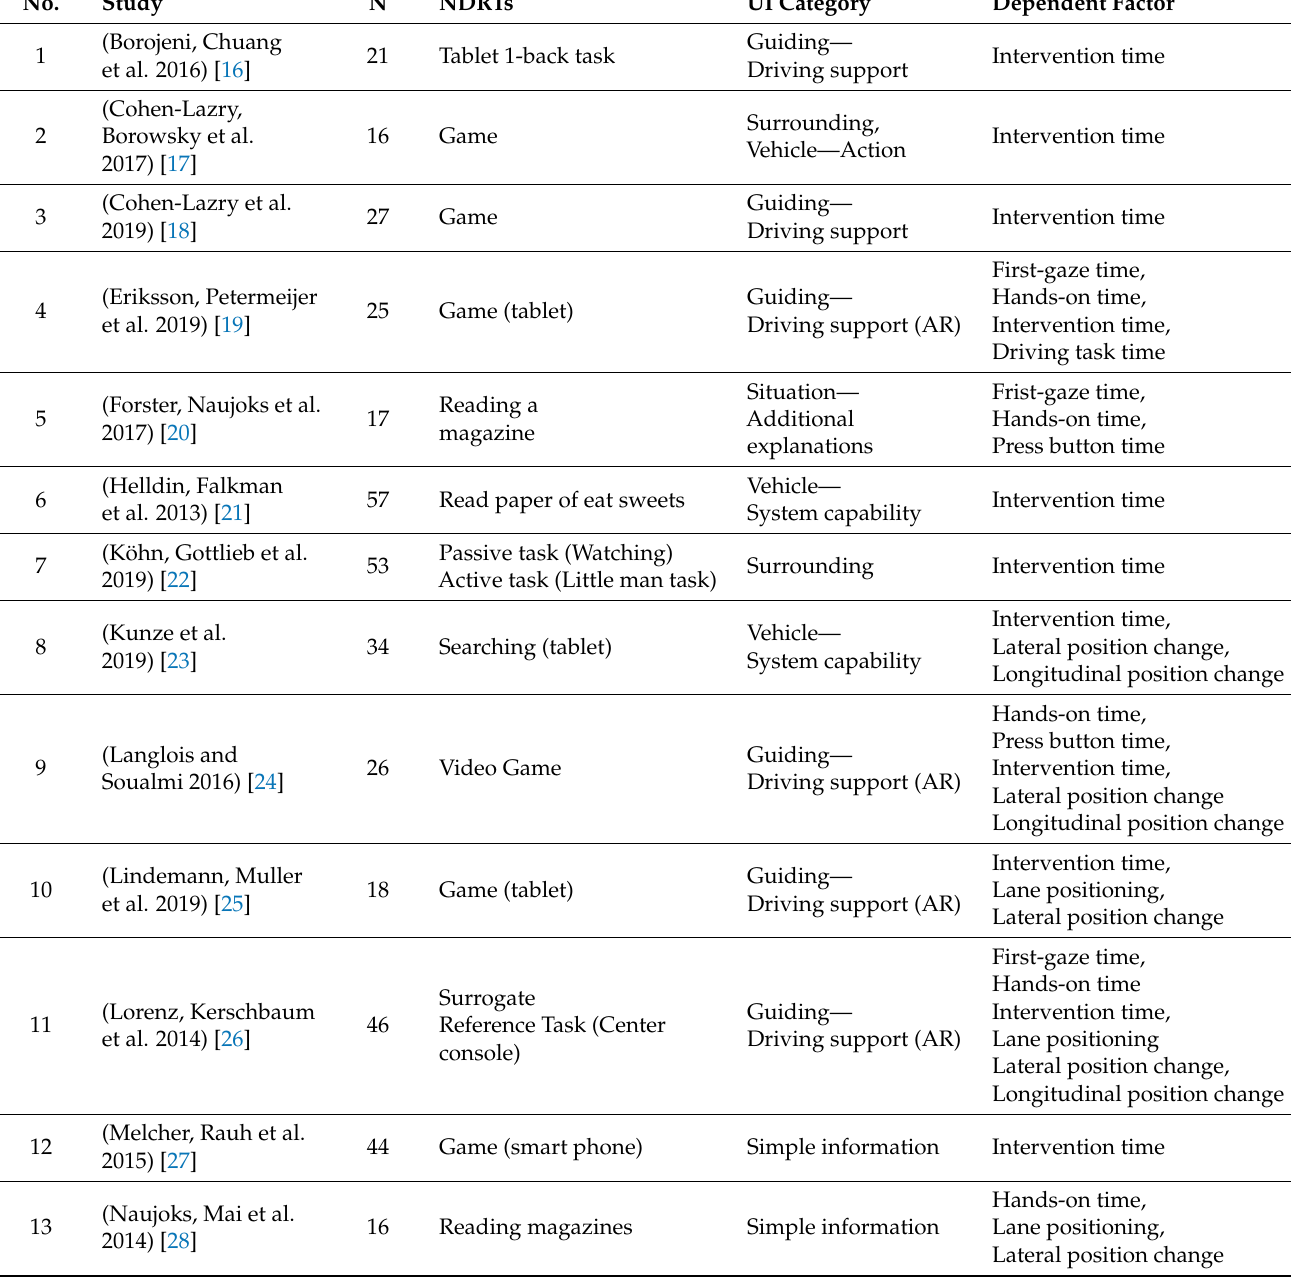
Table 2. UI category and take-over performance reported in the